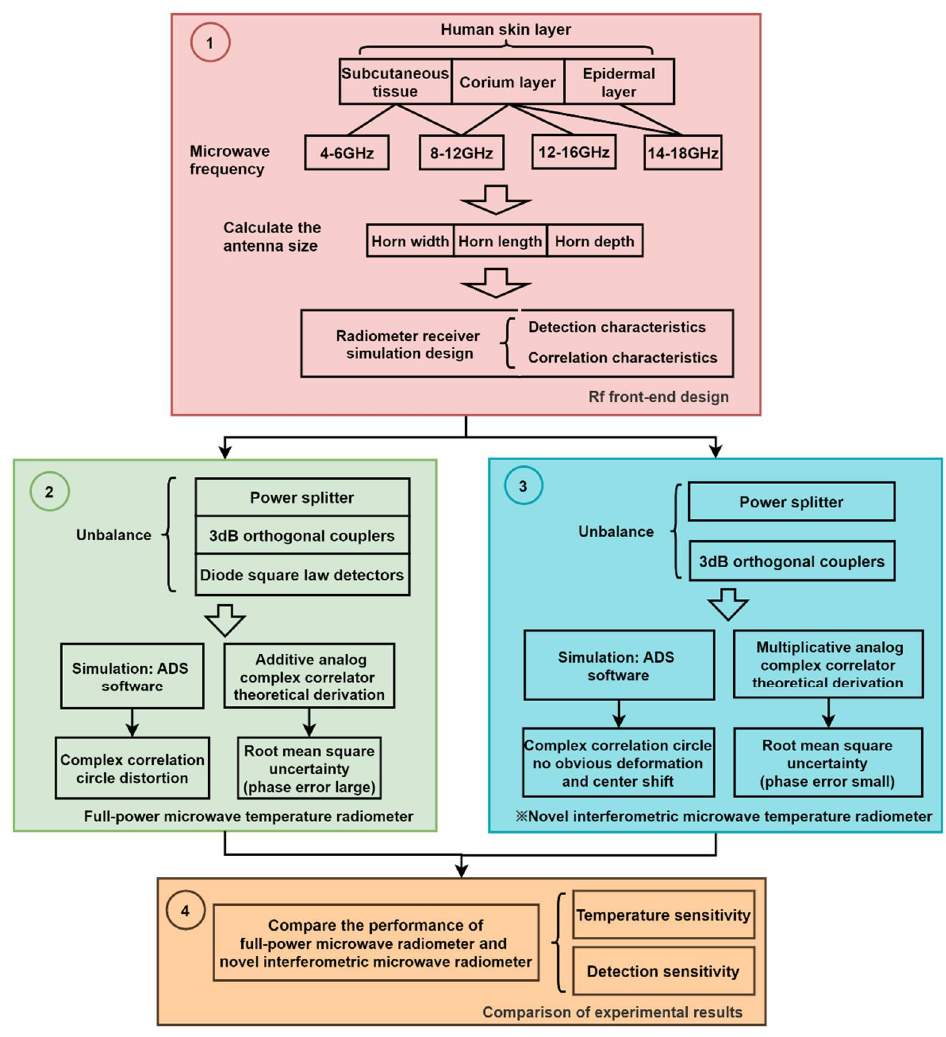
Figure 1. Overall scheme of the technical route.